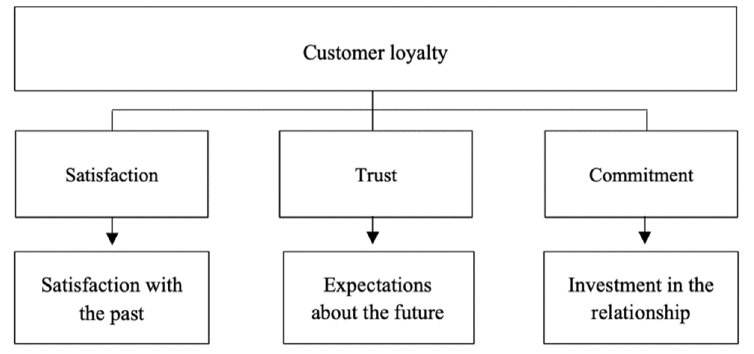
Figure 1. Drivers of customer loyalty.